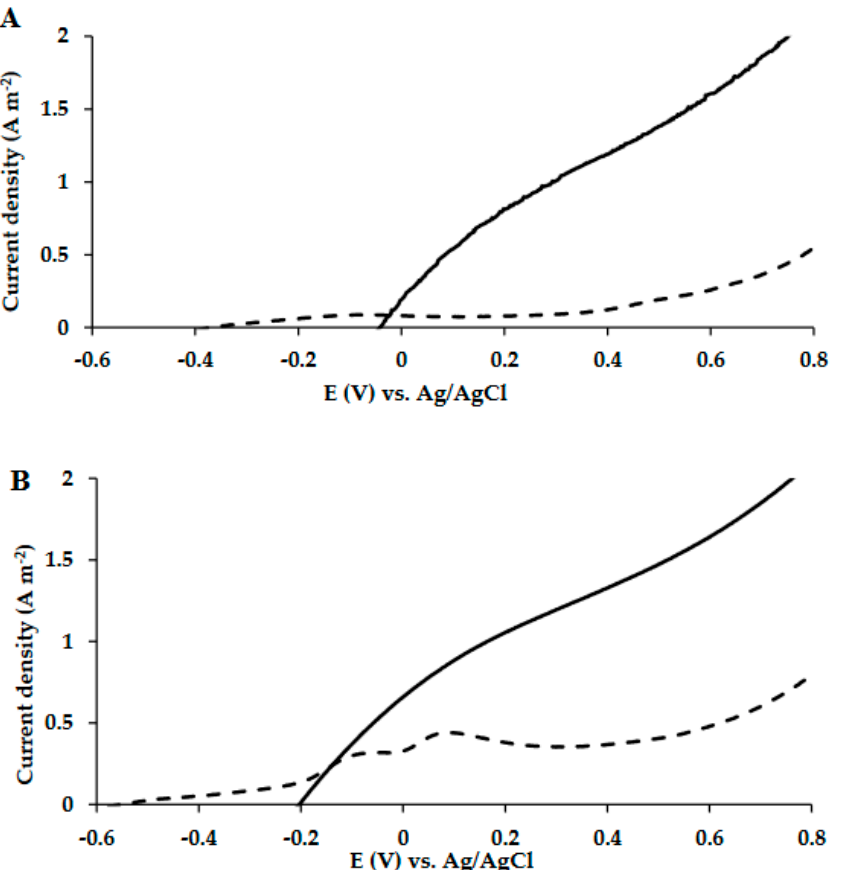
Figure 2. LSV polarization curves of MEC-SBP ( — ) and MEC control ( - - - ) supplied with Geobacter medium, and acetate as the sole carbon source. LSV analysis was carried out on the 14th ( A ) and 27th ( B ) days of the MECs’ operation, at a scan rate of 5 mV s − 1 versus Ag/AgCl.